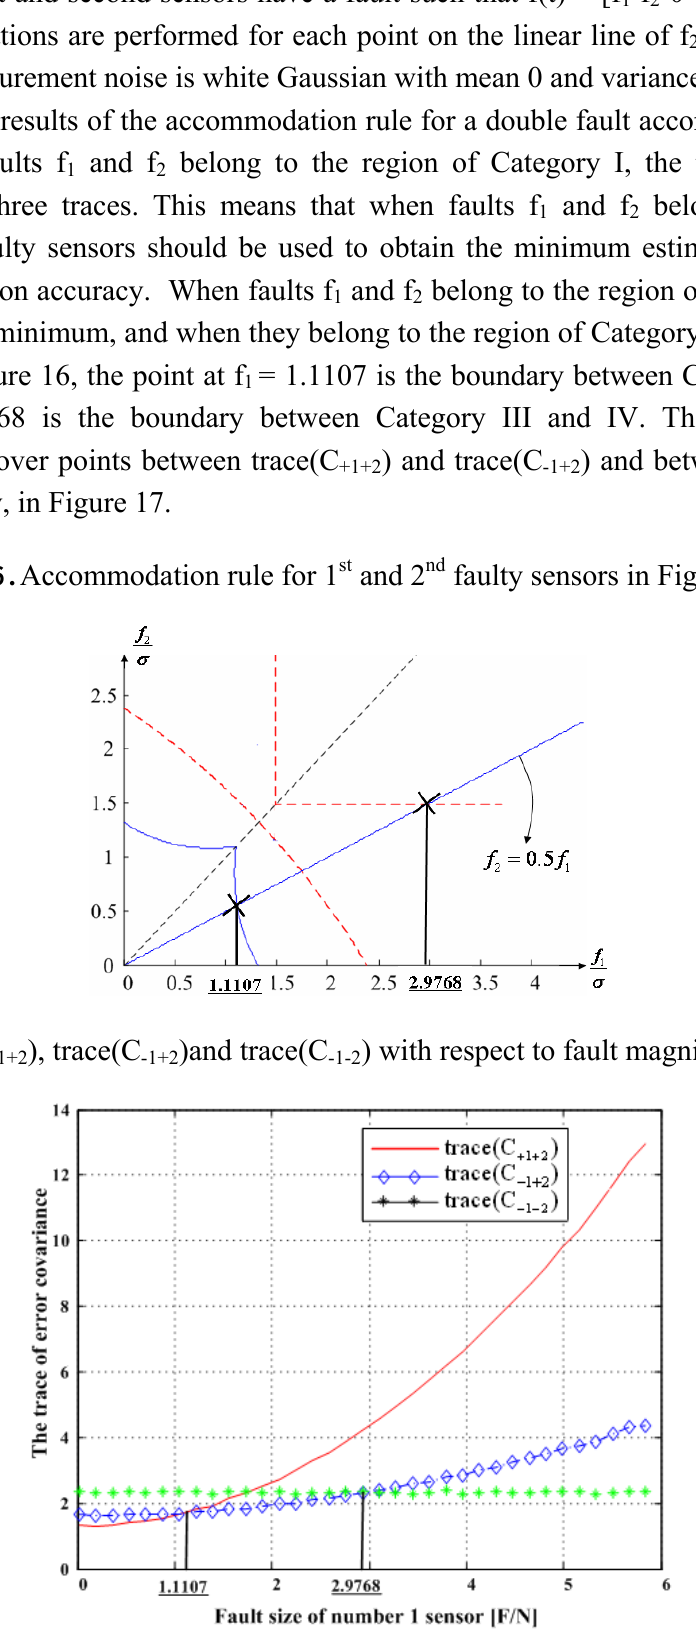
Figure 17. Trace(C